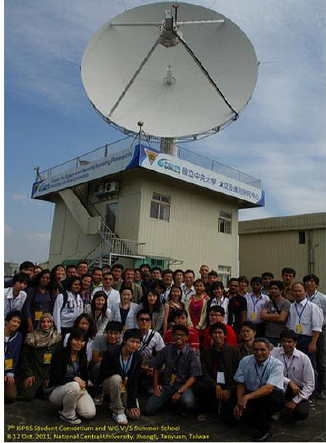
Figure 9. Participants of the Summer School held after ACRS 2010